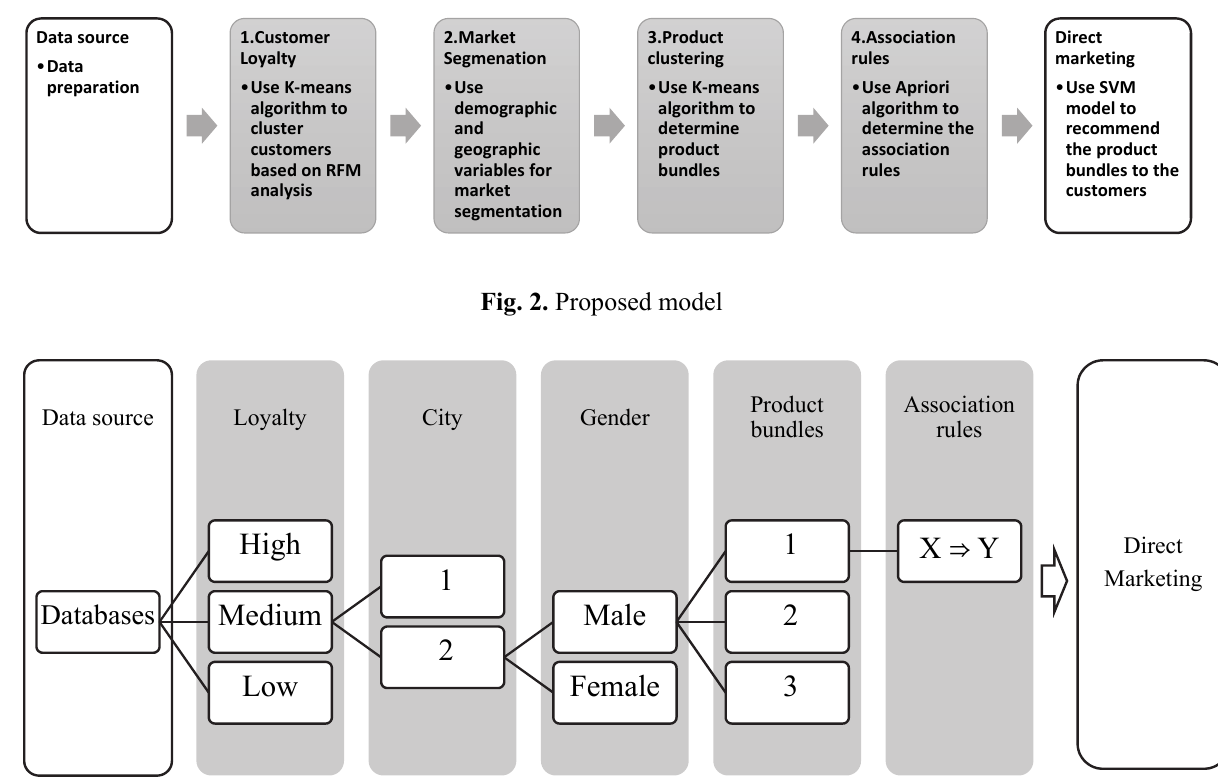
Fig. 3. An example of the steps of the proposed model